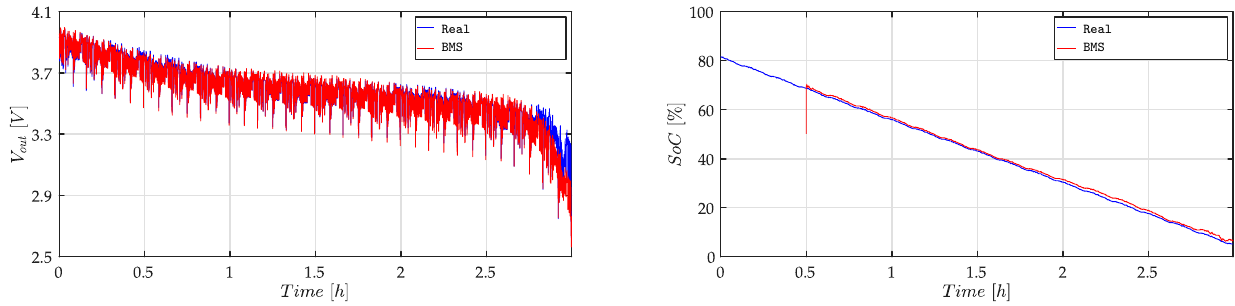
Figure A4. SoC and V out time series referring to the INR 18650-20R-US06 dataset considering the best PI-ENNC BMS model on the test set.